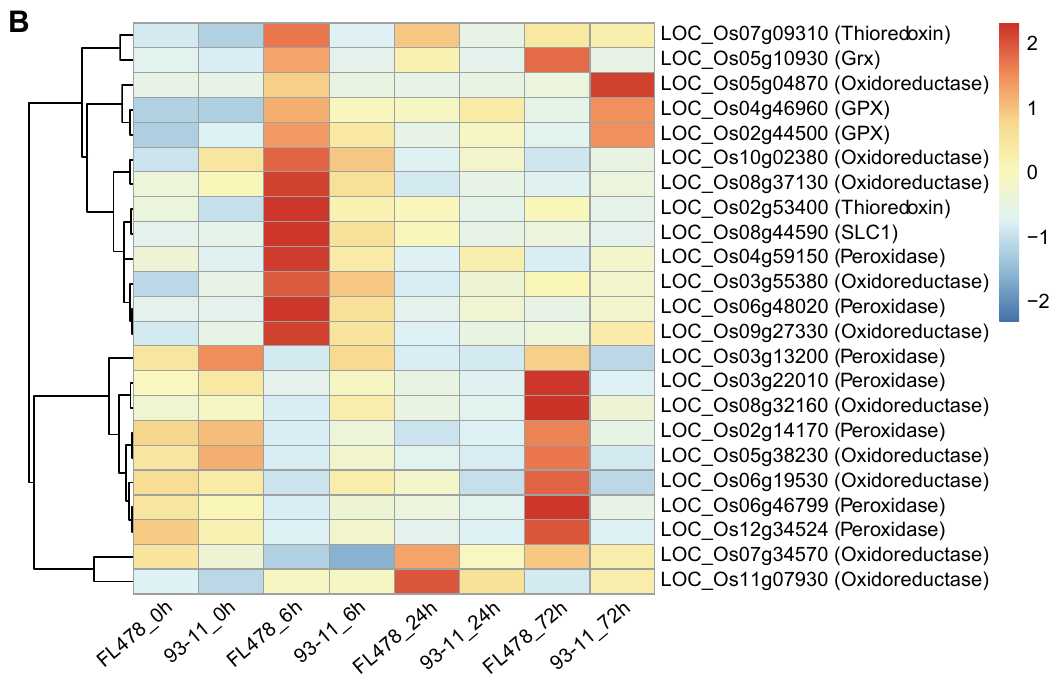
Figure 4. The expression profiles of salt tolerance genes related to TFs ( A ) and oxidoreductases ( B ). Normalized FPKM was used to create the heatmap.